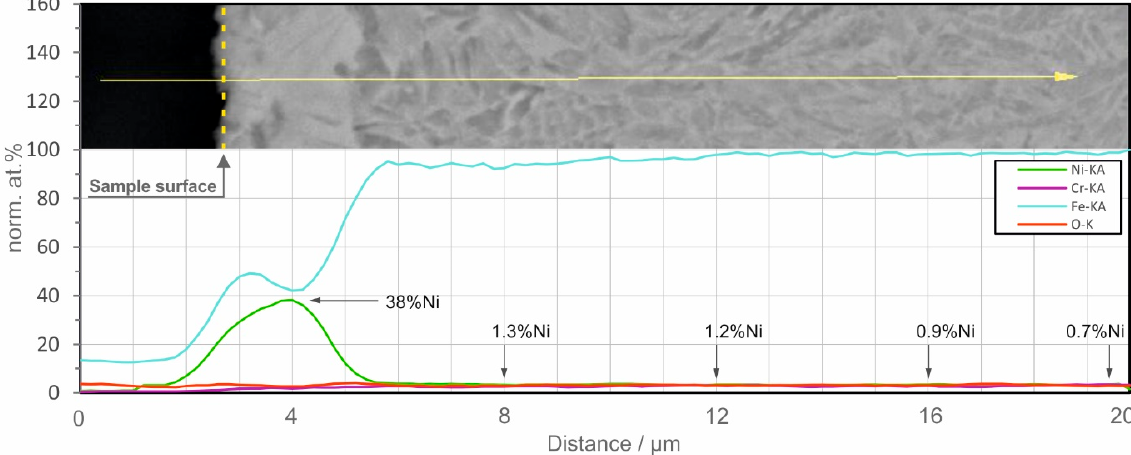
Figure 6. EDS line scan describing the elemental composition throughout the treated region.